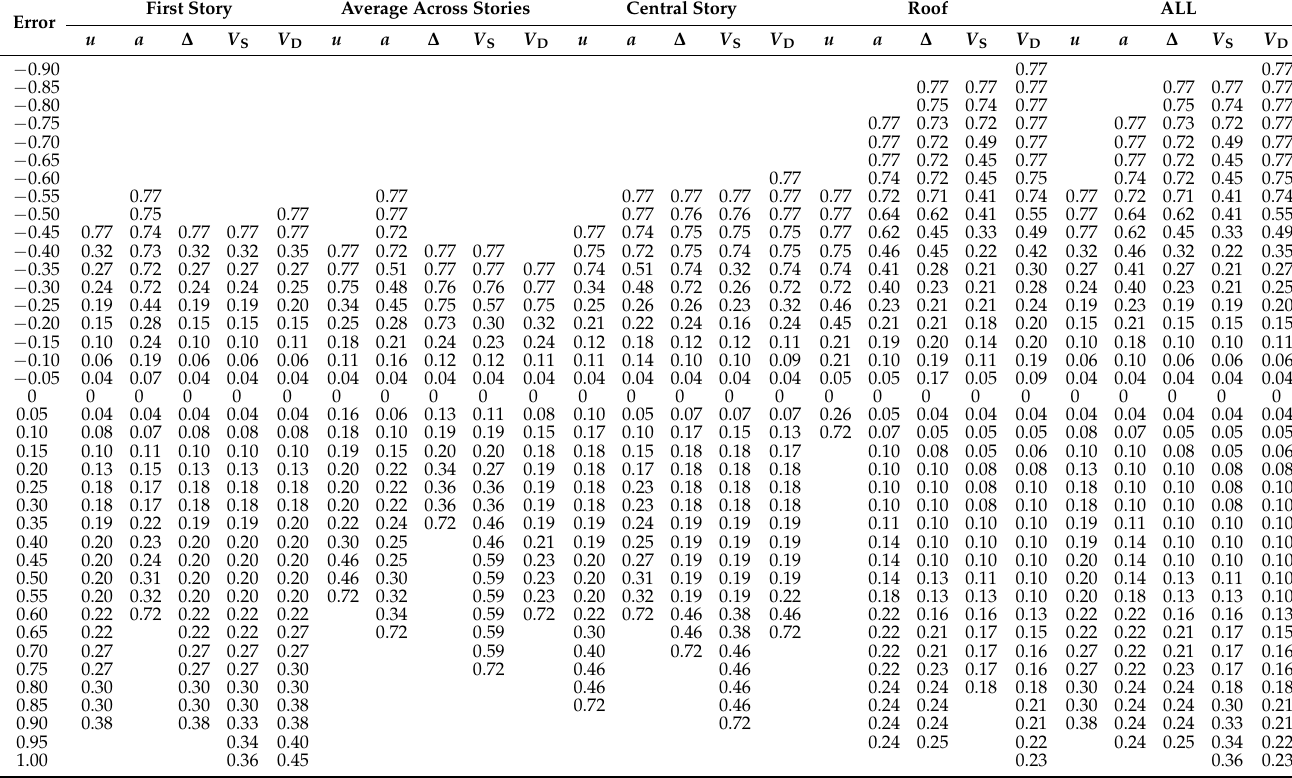
Table 7. Maximum value of I PS 5 to limit the max and min THMA error (error